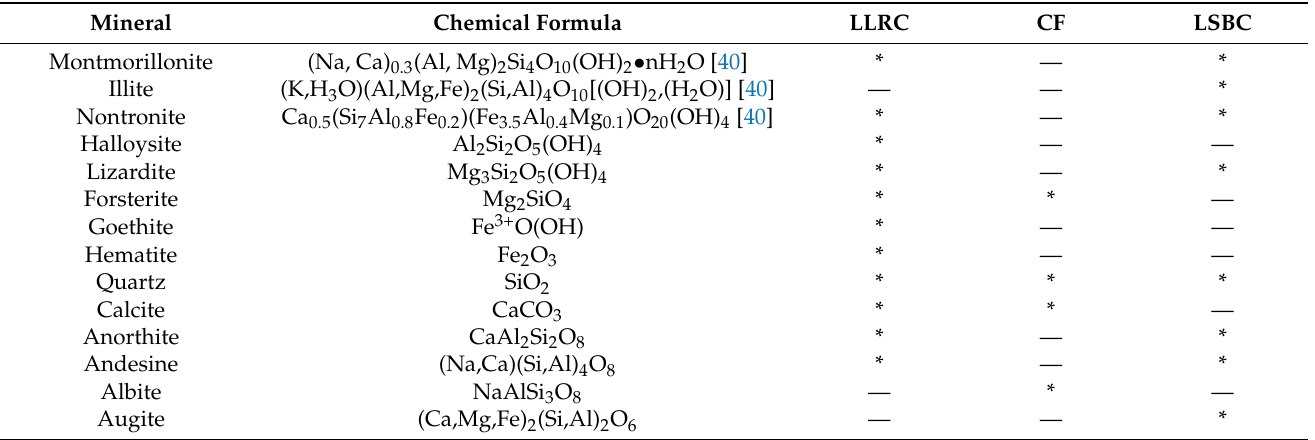
Figure 1. XRD patterns of raw materials: ( a ) LLRC; ( b ) CF; and ( c ) LSBC. Table 3. List of detected minerals for LLRC, CF and